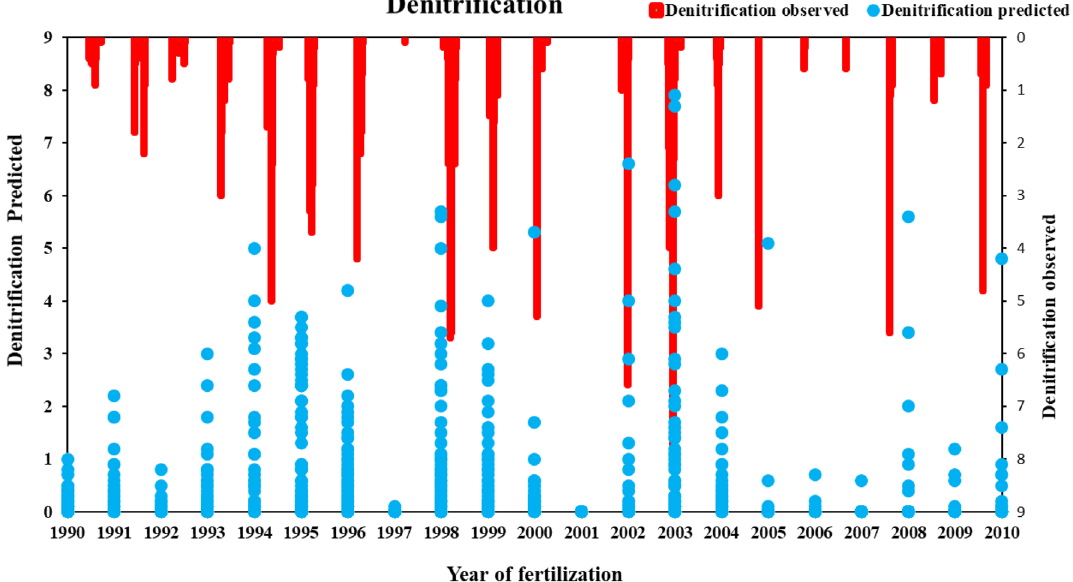
Figure 4. Denitrification rate over 20 years of fertilization of predicted and observed